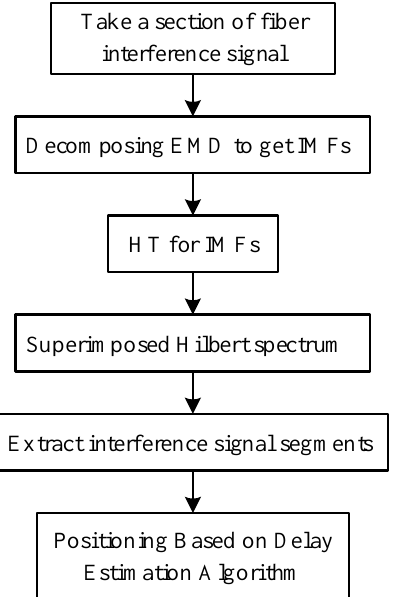
Figure 8. Flow chart of positioning calculation method.